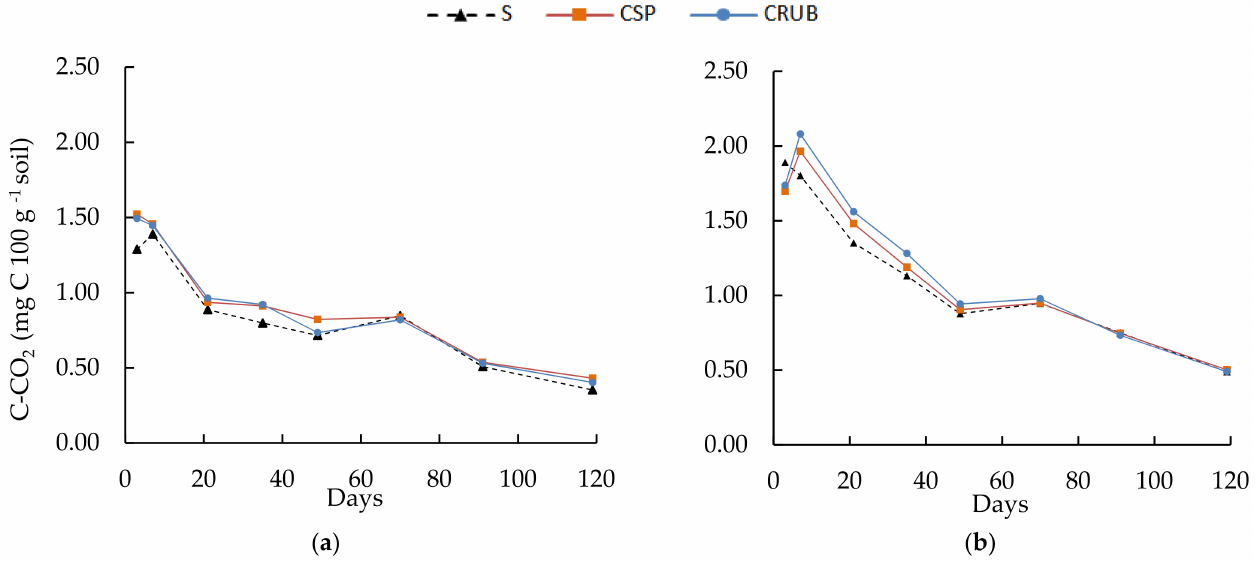
Figure 6. C-CO 2 evolvement: ( a ) S1; ( b ) S2. S: control. CSP: poultry manure and wheat straw; CRUB: biosolids and wood